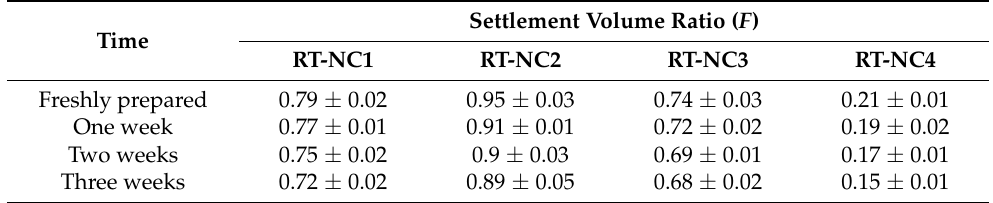
Table 3. Settlement volume ratios for various RT nanocrystals after storage at room temperature for various time periods.